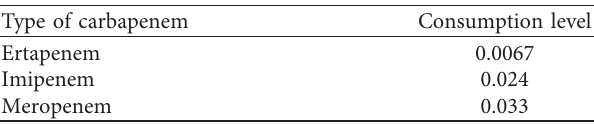
Table 1: Level of global carbapenem consumption according to the drug type during 2018.